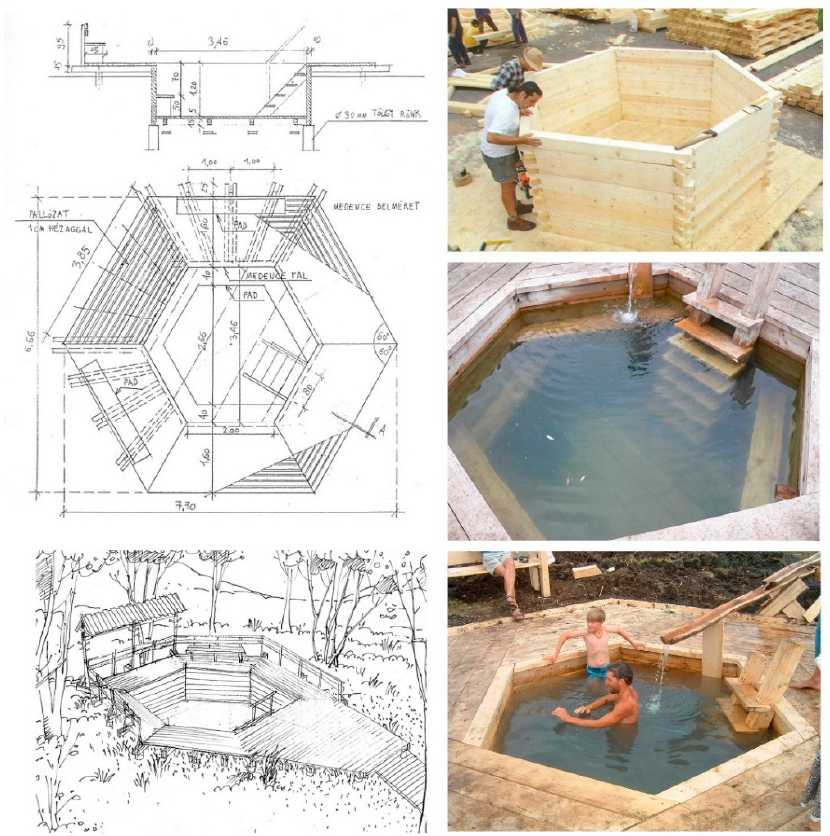
Figure 8. Design details, concept and renewed basin of the Szent Anna bath in Cs í kszenttam á s (Tomesti, Romania) in 2007. List of designers and contributors on the https://www.arstopia.hu/2007 kalaka (accessed on 5 December